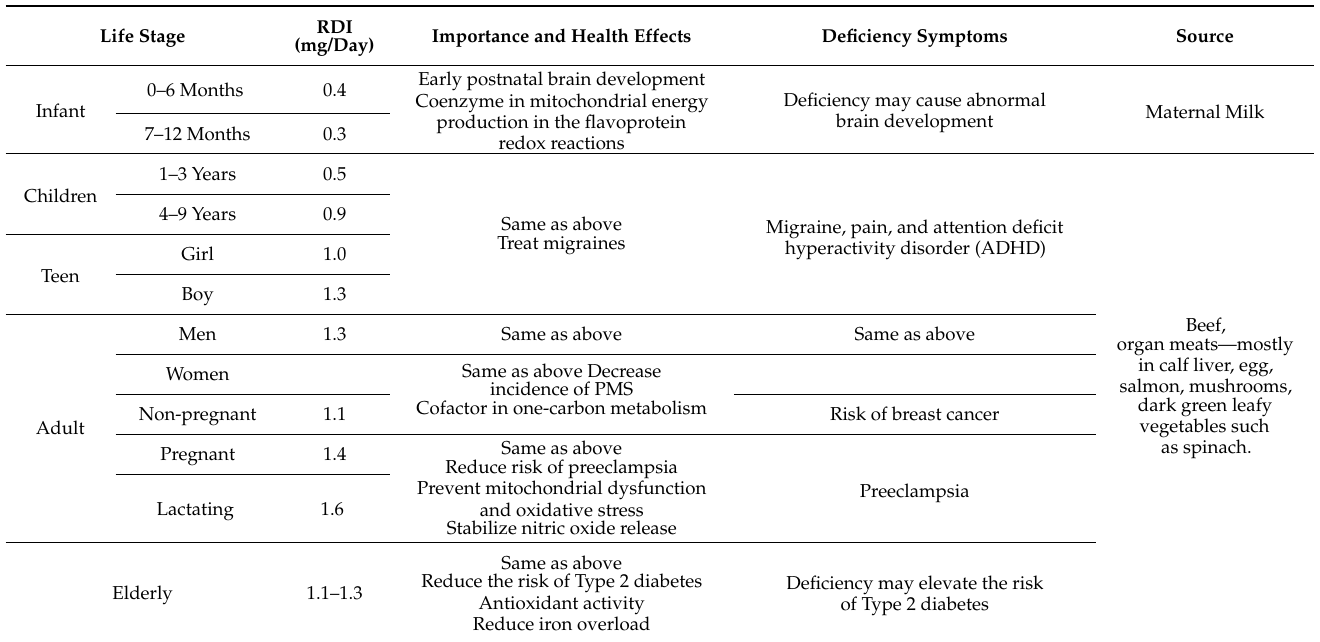
Table 2. Recommended daily intake (RDI), main action, and natural sources of vitamin B2 (riboflavin) in different life